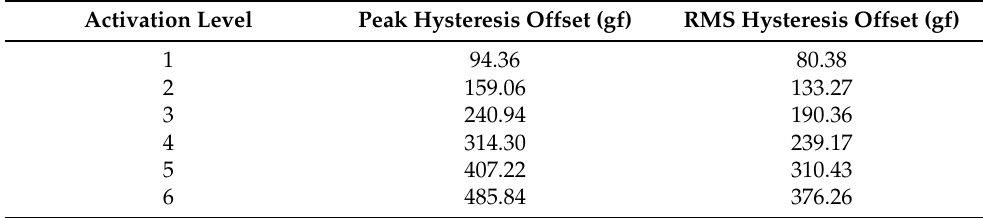
Table 4. Calculated peak and RMS hysteresis per activation level for the force characterisation experiment.